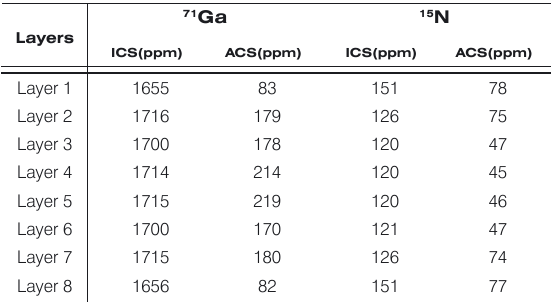
Table 3. The NMR parameters in the raw (4, 4) GaNNT.